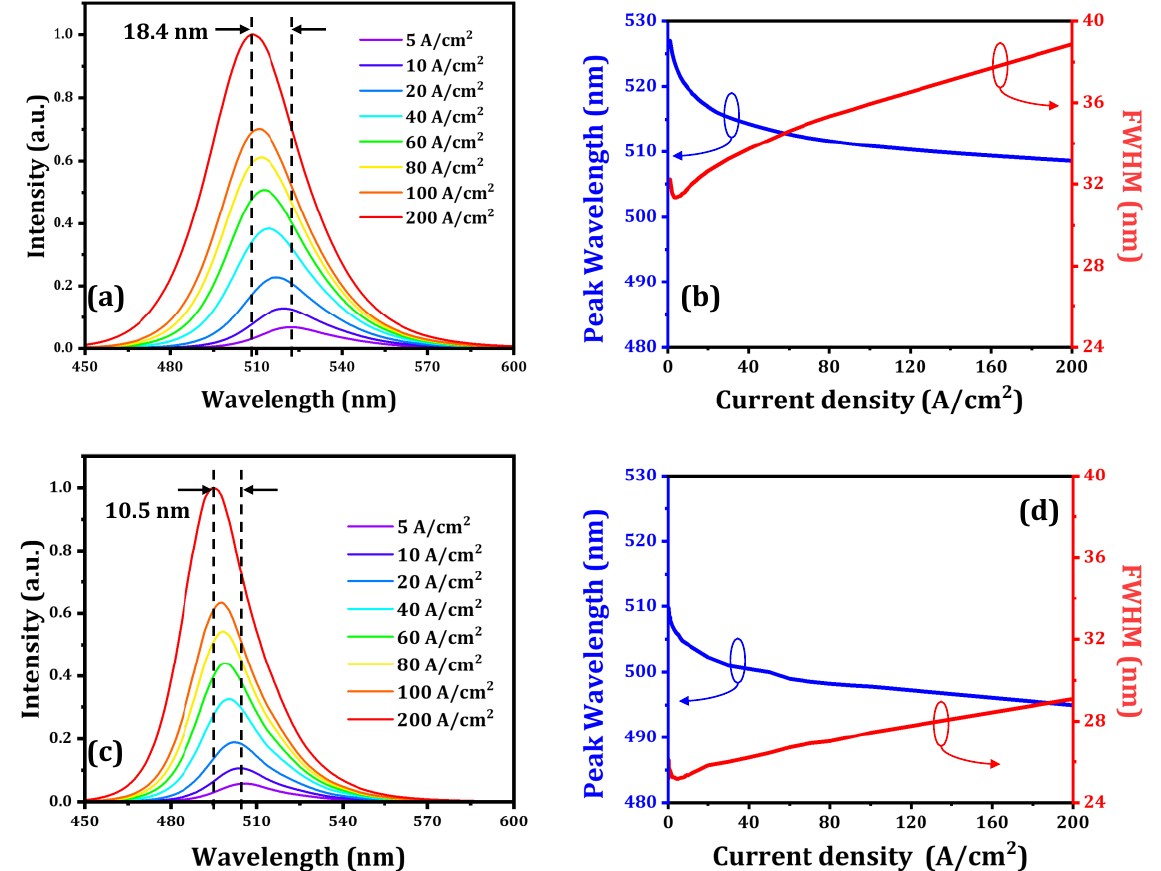
Figure 2. Measured ( a ) emission spectra and ( b ) wavelength shifts and FWHMs of the commercial green μ-LEDs with regular quantum wells. Measured ( c ) emission spectra and ( d ) wavelength shifts and FWHMs of μ-LEDs with staggered quantum wells.